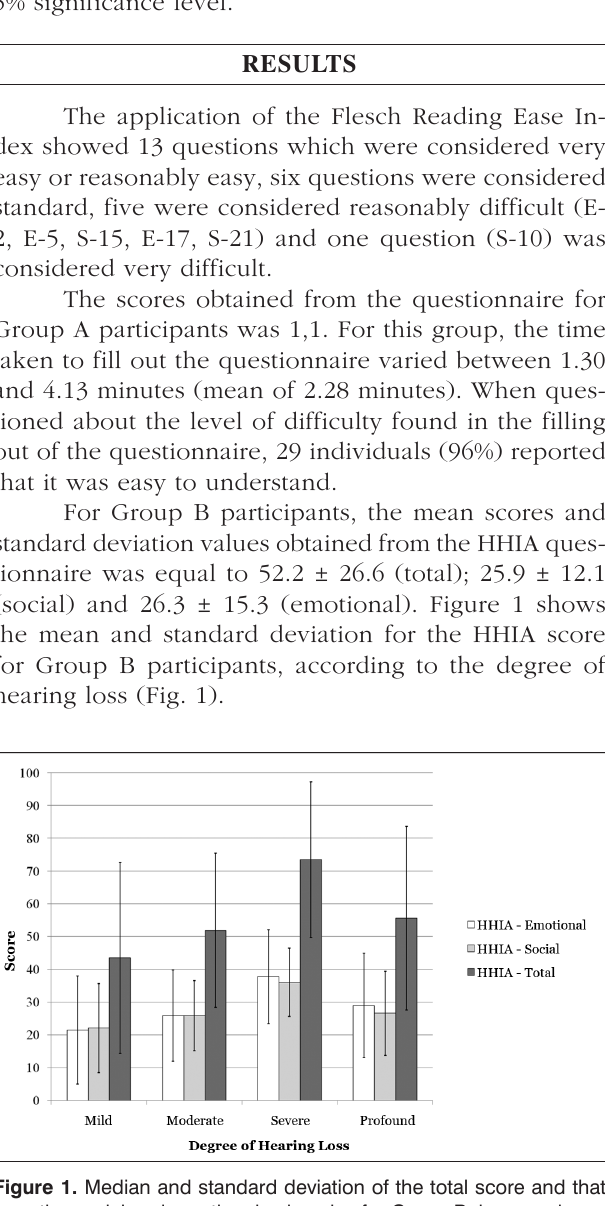
Table 2. Pearson’s correlation coefficient between the total score and that from the social and emotional subscales of the HHIA for Group B (n=113).